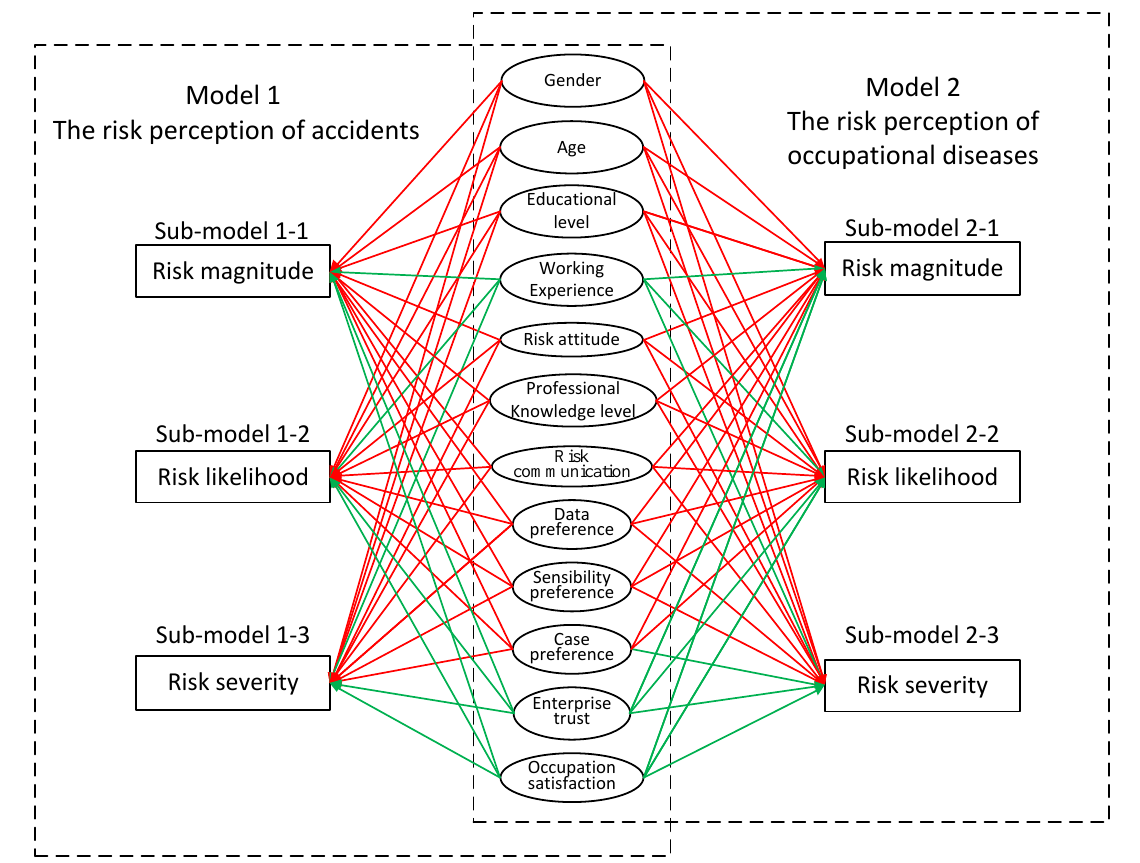
Note: The red lines indicate the hypothesis of positive correlation, and the green lines indicate the hypothesis of negative correlation. Figure 1. The hypothetical influencing factor